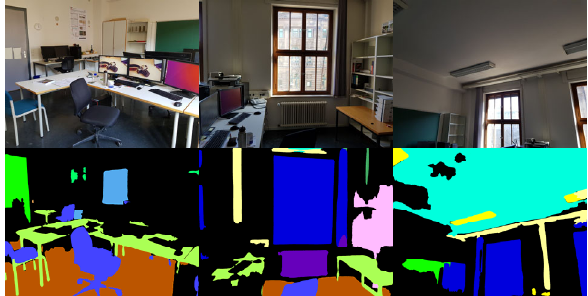
Figure 2. Figure 2: Exemplary results of using our trained DeepLabv3+ model for inferencing the images of an interior